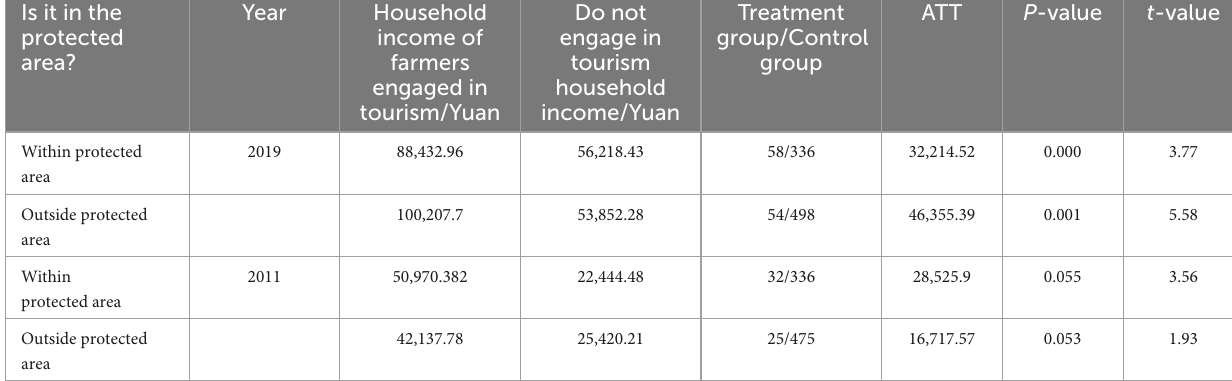
TABLE 6 Effect of tourism in and outside protected areas on the household income of farmers. Is it in the